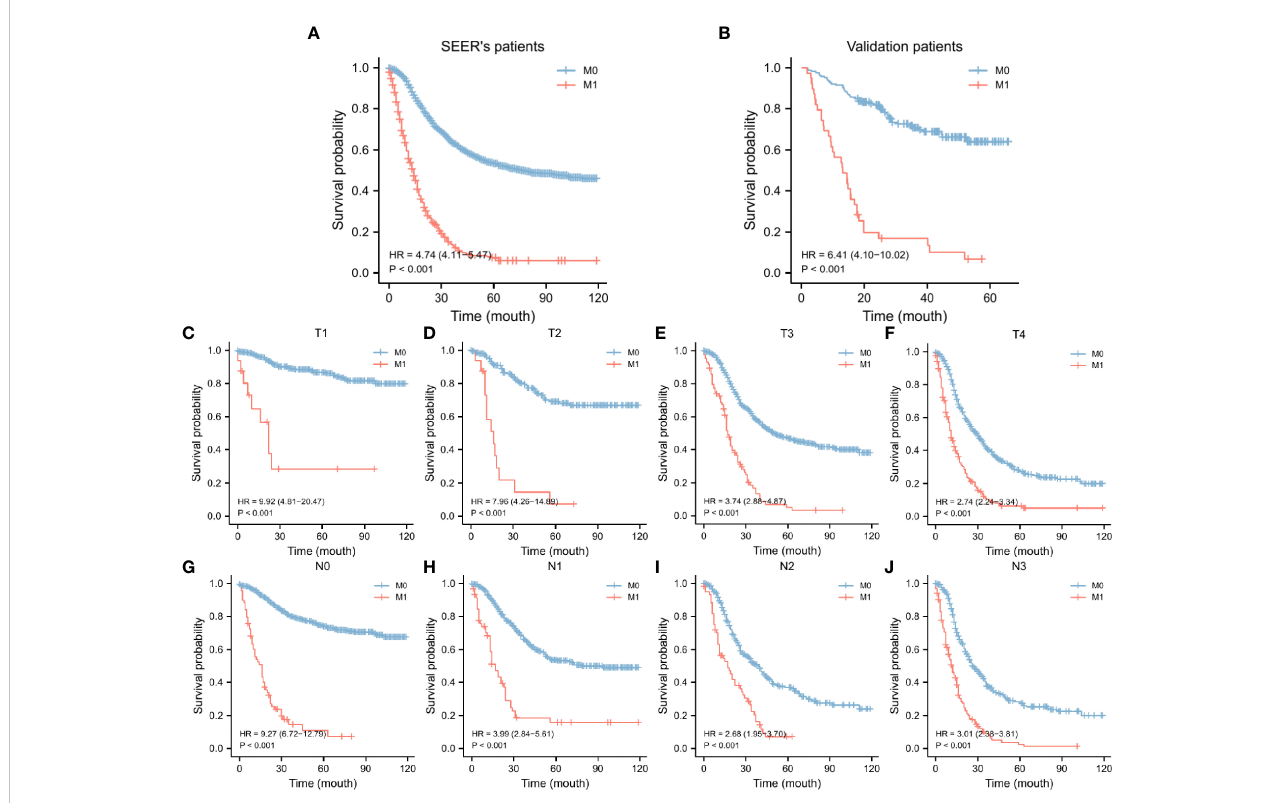
FIGURE 2 KM curves of OS for GC in the SEER data set (A) and our validation set (B) , KM curves of OS for GC in the T stages (C-F) and N stages (G-J) . SEER, Surveillance, Epidemiology, and End Results database; OS, overall survival; GC, gastric cancer; KM curve, Kaplan-Meier curve.